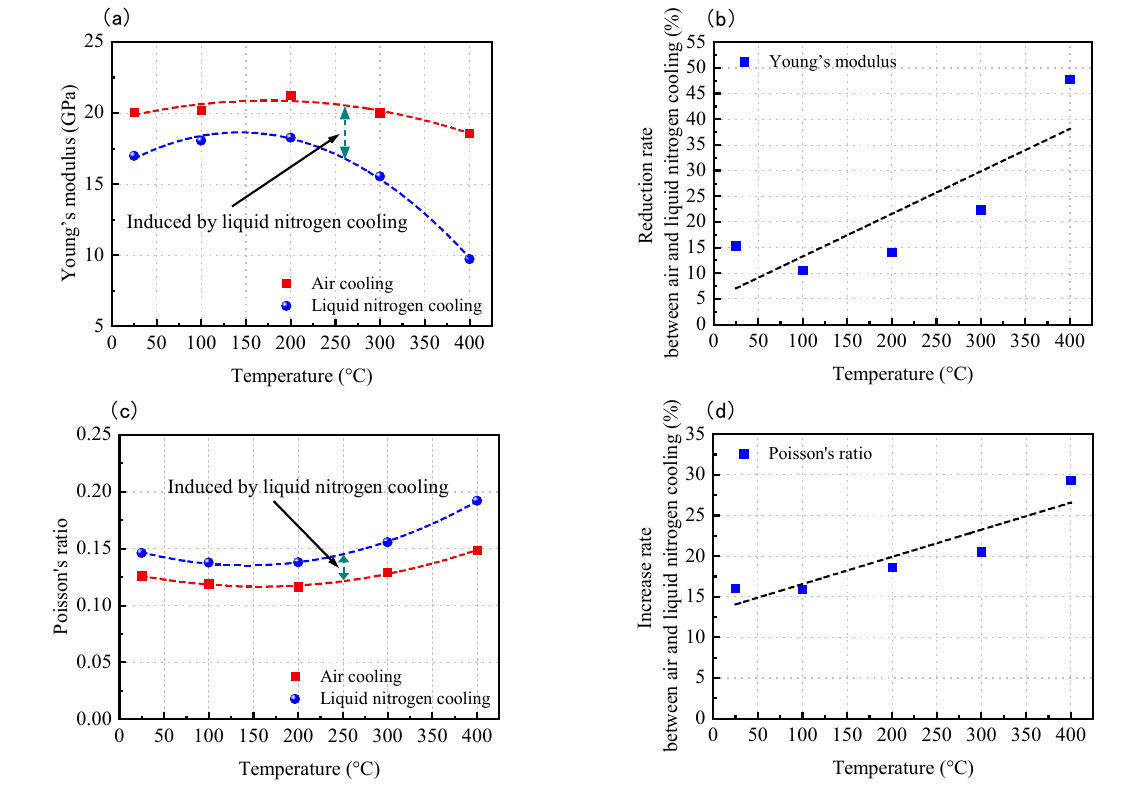
Figure 5. Effect of liquid nitrogen cooling on deformability: ( a ) Young’s modulus, ( b ) reduction rate of Young’s modulus between air and liquid nitrogen cooling, ( c ) Poisson’s ratio, and ( d ) increase rate of Poisson’s ratio between air and liquid nitrogen